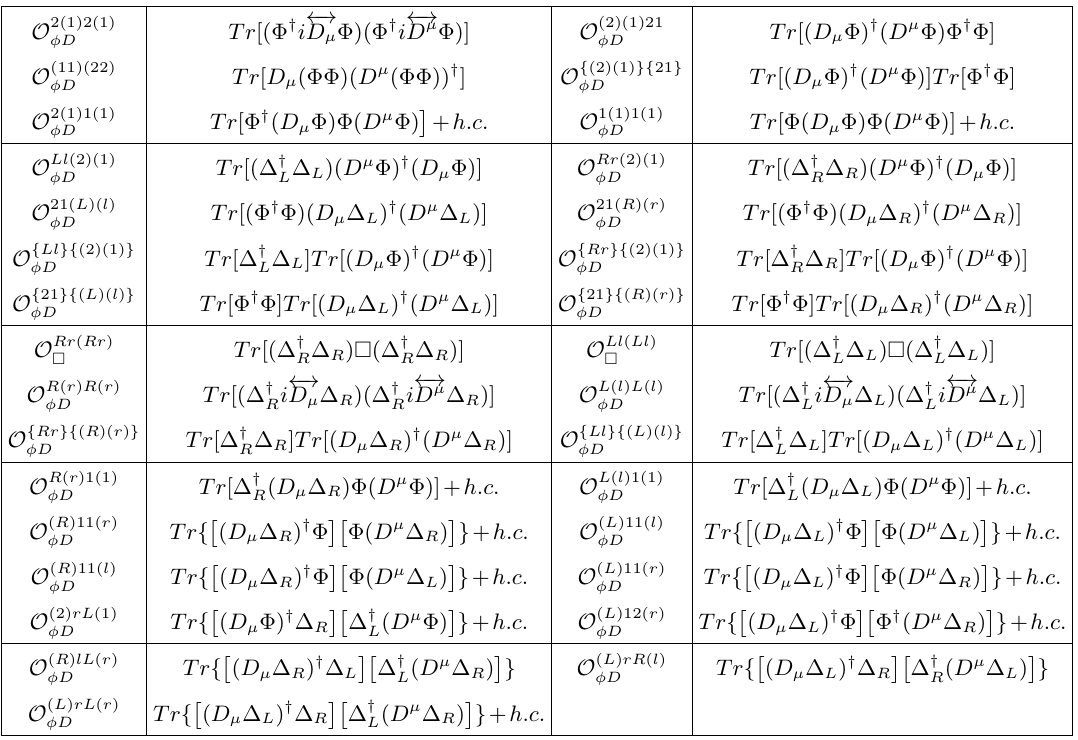
Table 24. MLRSM: (cid:30) 4 D 2 [20 + 11